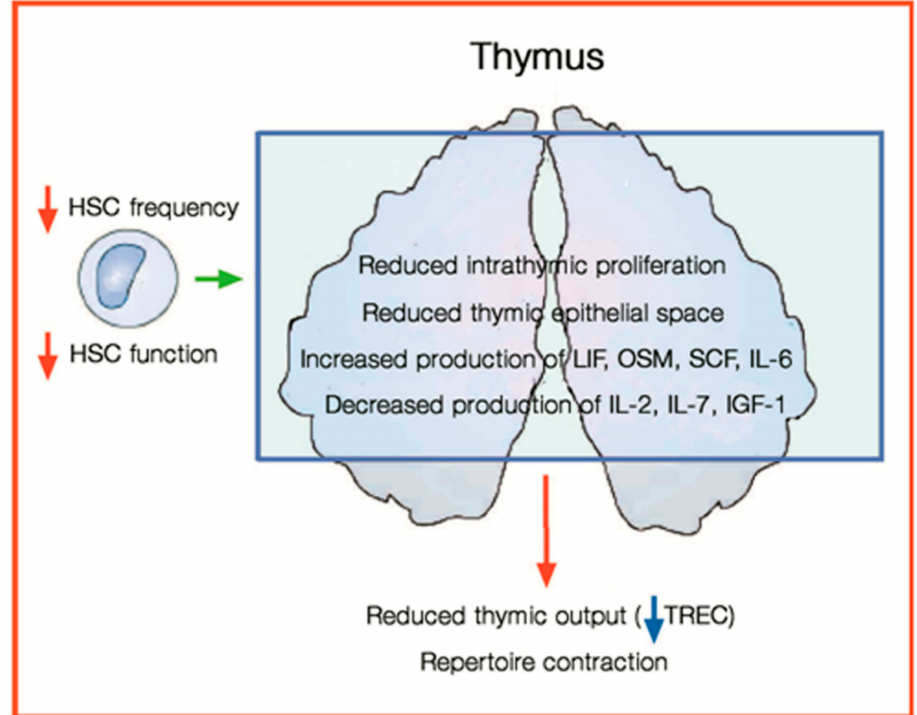
Figure 2. Main aspects of thymic involution. The decrease of hematopoietic cells causes a decrease of production of T cells from the thymus. HSC: hematopoietic stem cells; LIF: leukemia- inhibitory factor; OSM: Oncostatin M; SCF: stem cell factor; IL-2: interleukin 2; IL-6 interleukin 6; IL-7: interleukin 7; IGF-1: insulin-like growth factor 1; TREC: T cell receptor excision circles (modified from